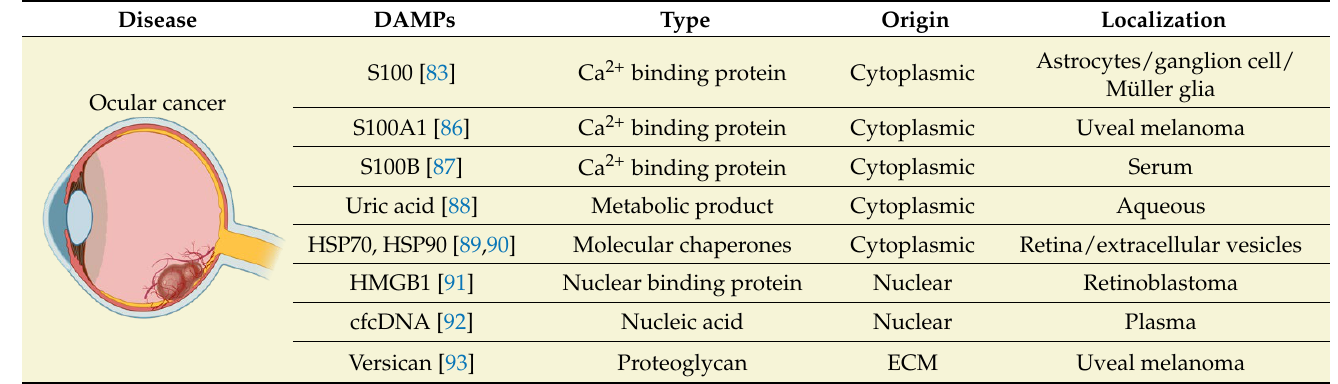
Table 4. DAMPs in ocular cancer.